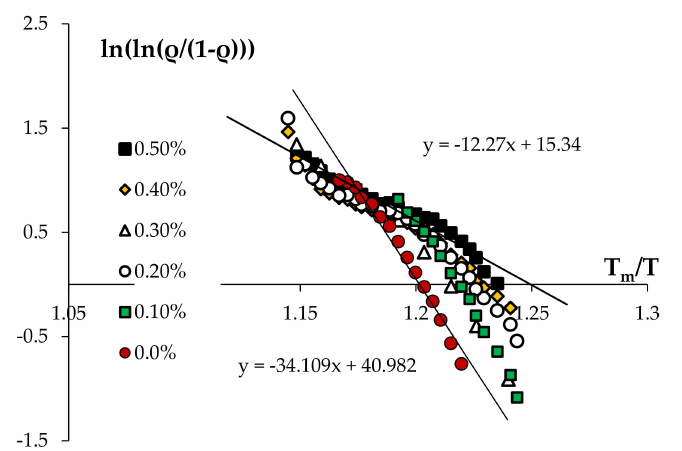
Figure 13. Dependence of density represented in double-logarithmic coordinates on reciprocal temperature for the WC-10Co hard alloy sintered from submicron powder with a 0.5 wt.% graphite content. Determination of the sintering activation energy at higher